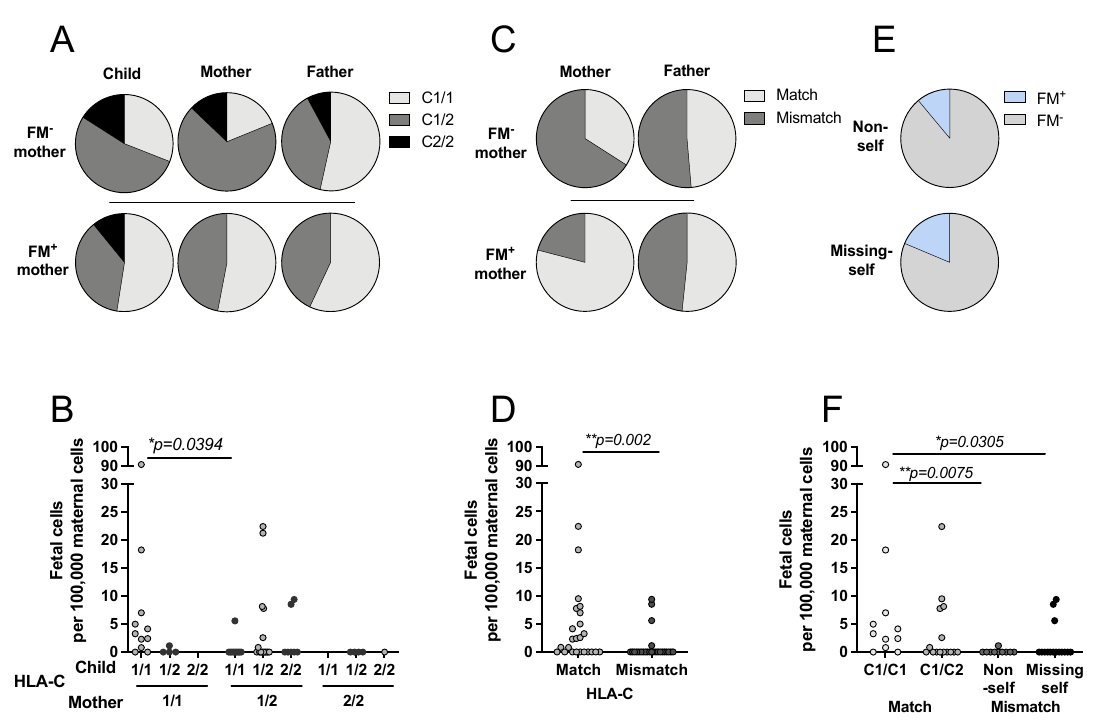
Figure 2. FM is favored in HLA-C matched mother–child pairs. Frequency and level of FM were analyzed in regard to filial or parental HLA-C genotypes. Child, mother, and father were grouped according to their HLA-C genotype into C1 or C2 homozygous or C1/C2 heterozygous. ( A ) Fre- quencies in child, mother and father grouped into FM + and FM − . ( B ) Level of FM in mother–child pairs grouped depending on their HLA-C genotype. ( C ) Frequencies of HLA-C match or mismatch between parent and child were compared in the FM + and FM − groups. ( D ) Level of FM was com- pared between matched or mismatched mothers. ( E ) Frequencies of FM + and FM − mothers, grouped depending on their mismatch either in non-self or missing-self. ( F ) Level of FM in all mothers grouped into match or mismatch; the mismatch cohort was further subdivided into non-self or missing-self. Criteria for grouping into HLA-C match and mismatch are depicted in Supplementary Fig- ure S1, B. FM was determined in mothers using ddPCR. Exact n values are provided in Supplementary Table S2. Statistical analysis of frequencies was performed using Fisher’s exact test for two groups or Chi 2 for more than two. Mann–Whitney test or Kruskal–Wallis test followed by Dunn´s multiple comparison test was used to analyze differences in FM levels. Statistical significance * p < 0.05; ** p < 0.01.